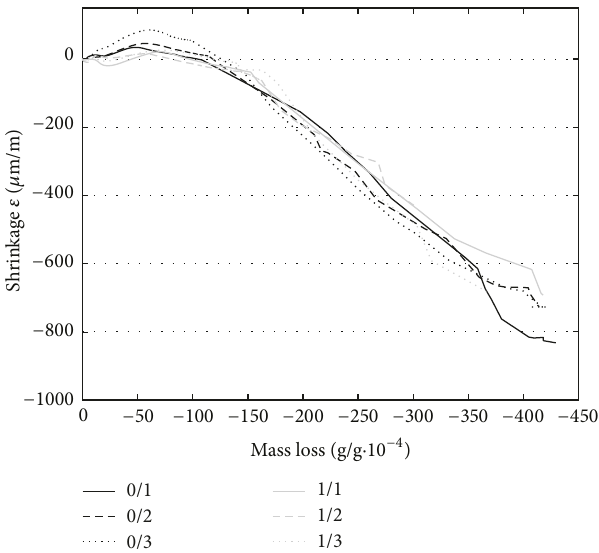
Figure 9: Relationship between shrinkage and mass loss for all investigated